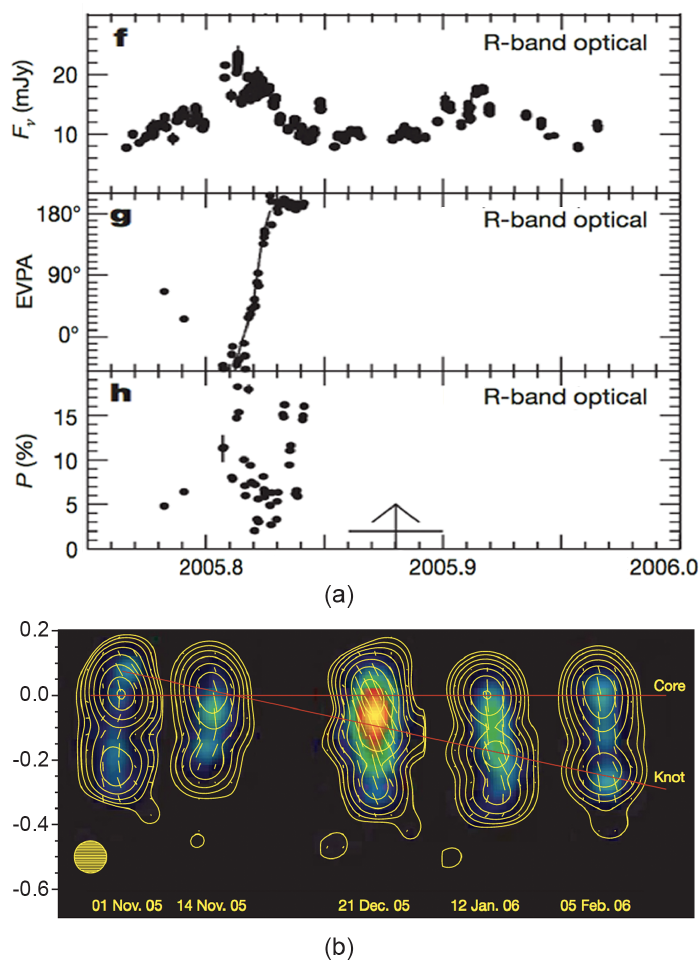
Figure 2. Time evolution of BL Lac. ( a ) Optical flux, electric vector position angle and polarization. ( b ) A 43 GHz VLBI component. A clear flare together with a polarization decrease and a rotation of about 240 ◦ of the optical EVPA is seen together with the emergence from the core of a new VLBI component. (Reprinted by permission from Springer Nature, 2008 [52] with permission of the